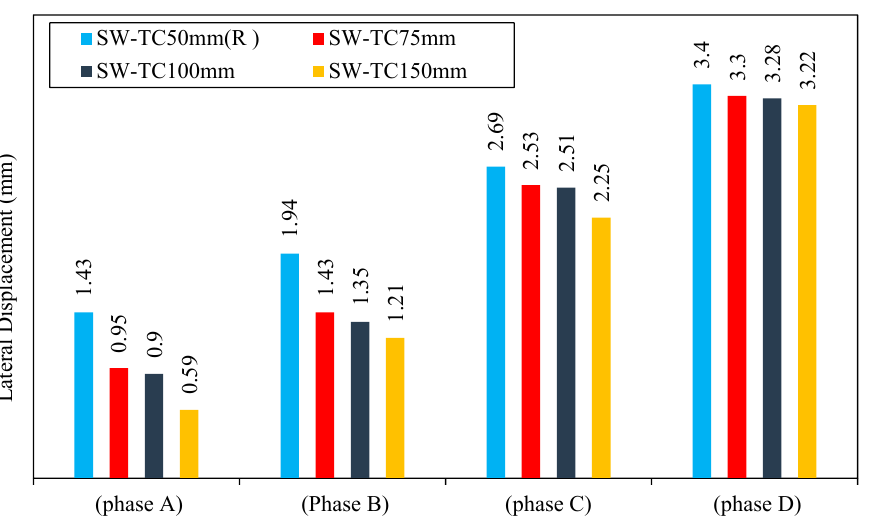
Figure 19. Lateral displacement of group 3.